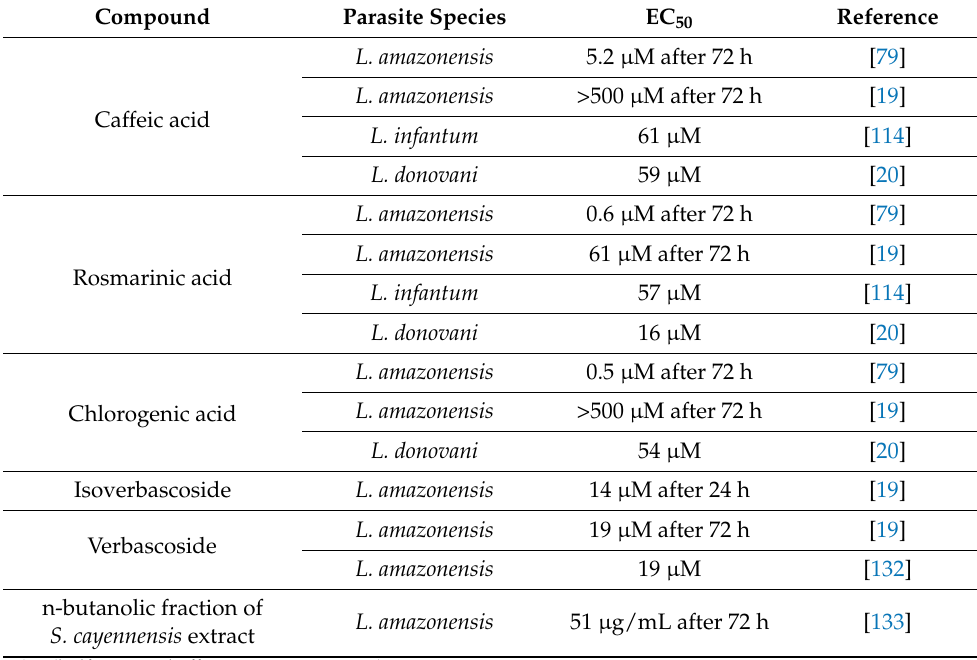
Table 9. Inhibition of Leishmania promastigotes with cinnamic acid